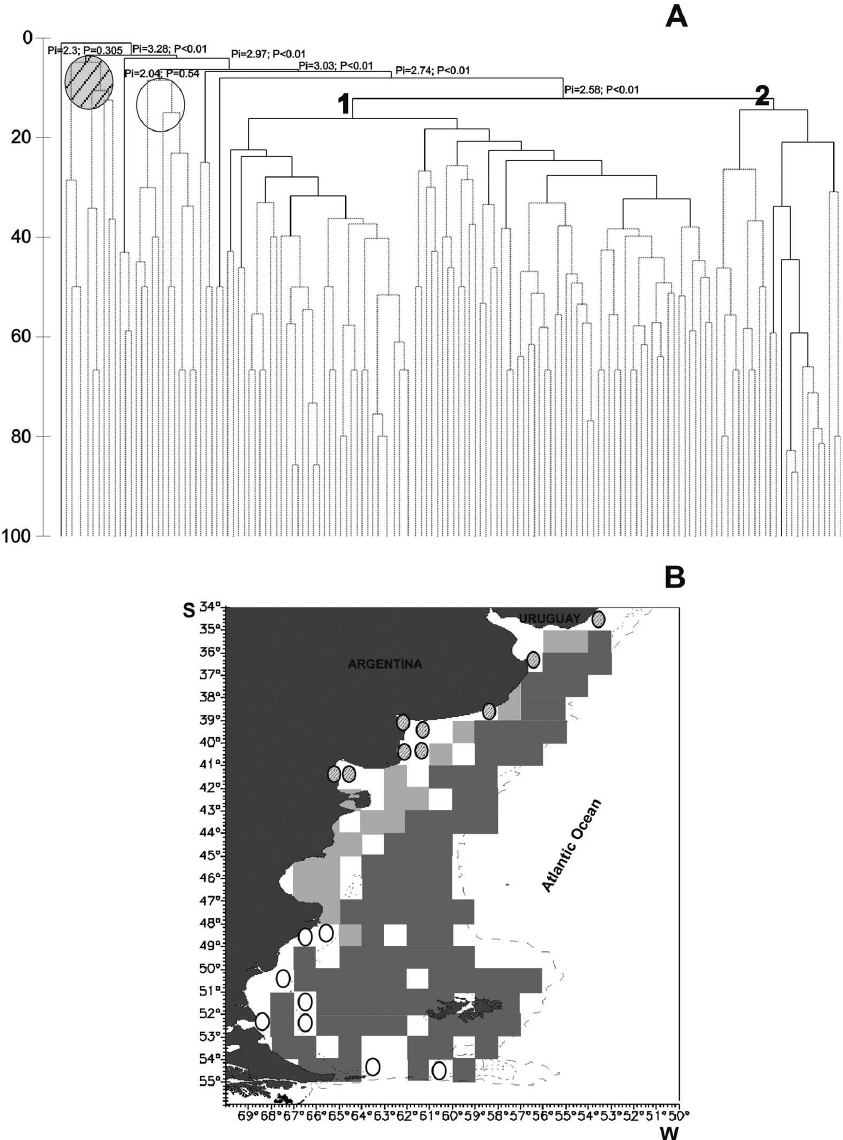
Fig. 5. – Echinoderm assemblages. A, SIMPROF analysis between squares. Values in the dendrogram show the significance in the formation of groups; and B, Geographic distribution in the study area. Group 1, dark grey squares; Group 2, light grey squares; coastal Buenos Aires and Uruguay, dashed circles; coastal Patagonia, white